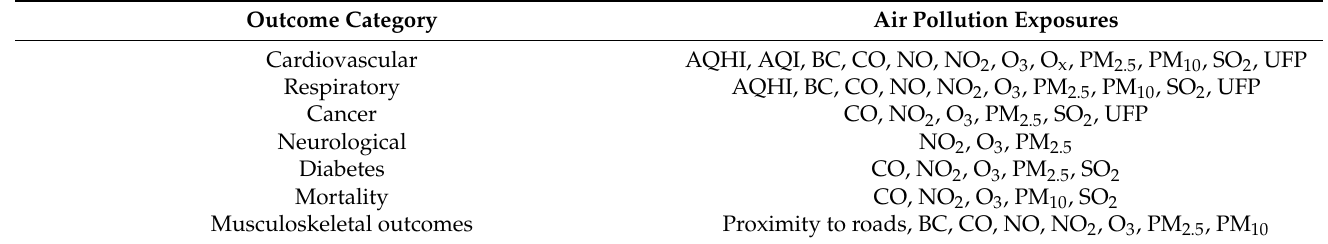
Table 3. Summary of outcomes and associated air pollution exposures in older adults. Outcome